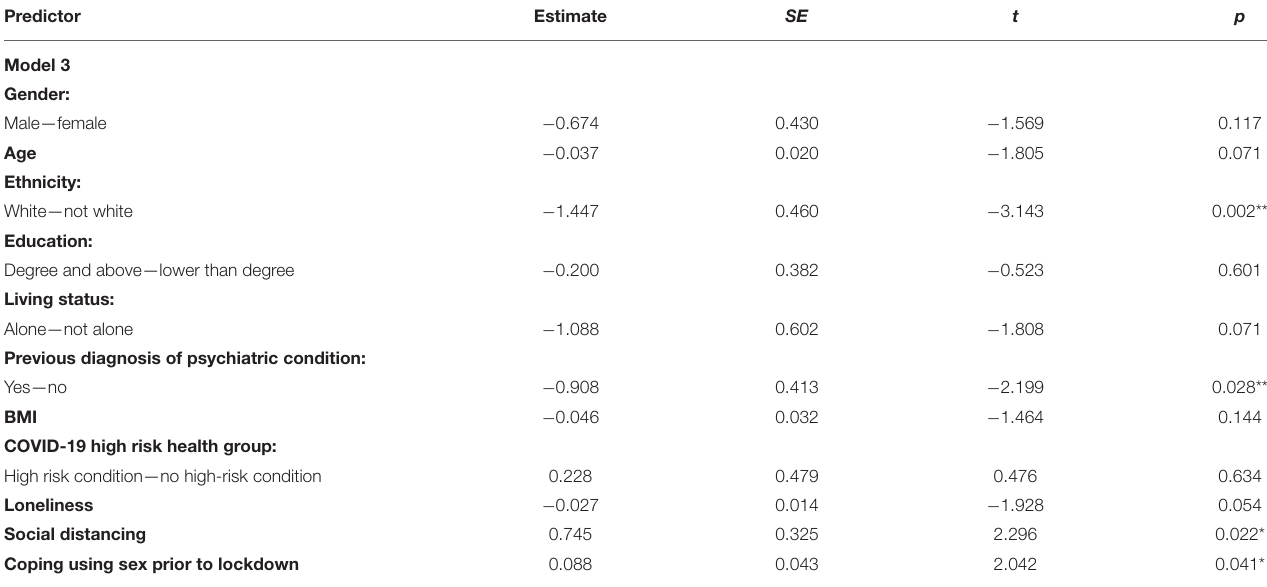
TABLE 2 | Results of multiple linear regression on perceived change in health-related behaviors. Predictor Estimate SE t p Model